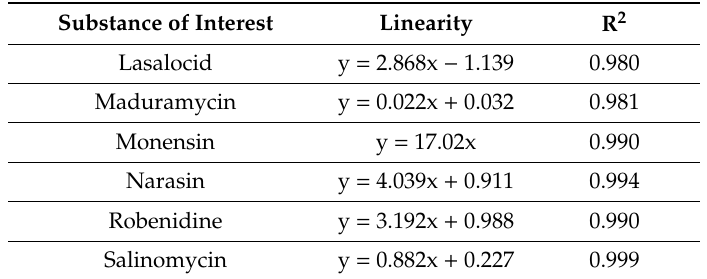
Table 2. Linear regression equations for the relationships between substance of interest / nigericin peak area ratios and substance of interest concentrations.